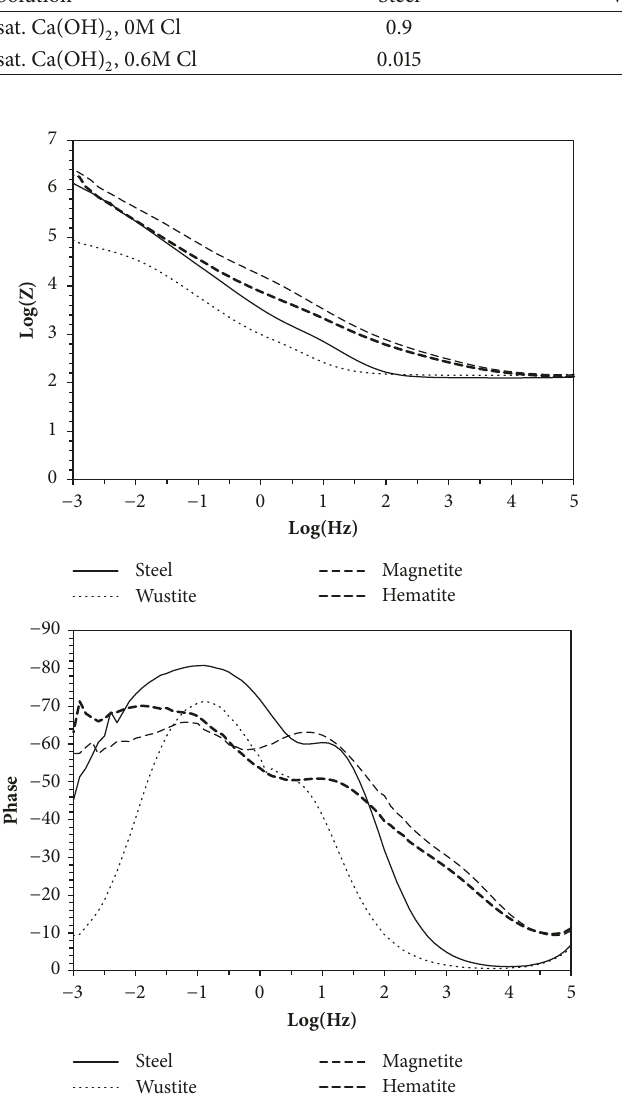
Figure 4: Example of Bode plots obtained in sat. Calcium hydroxide solution with 0.6 M Cl −